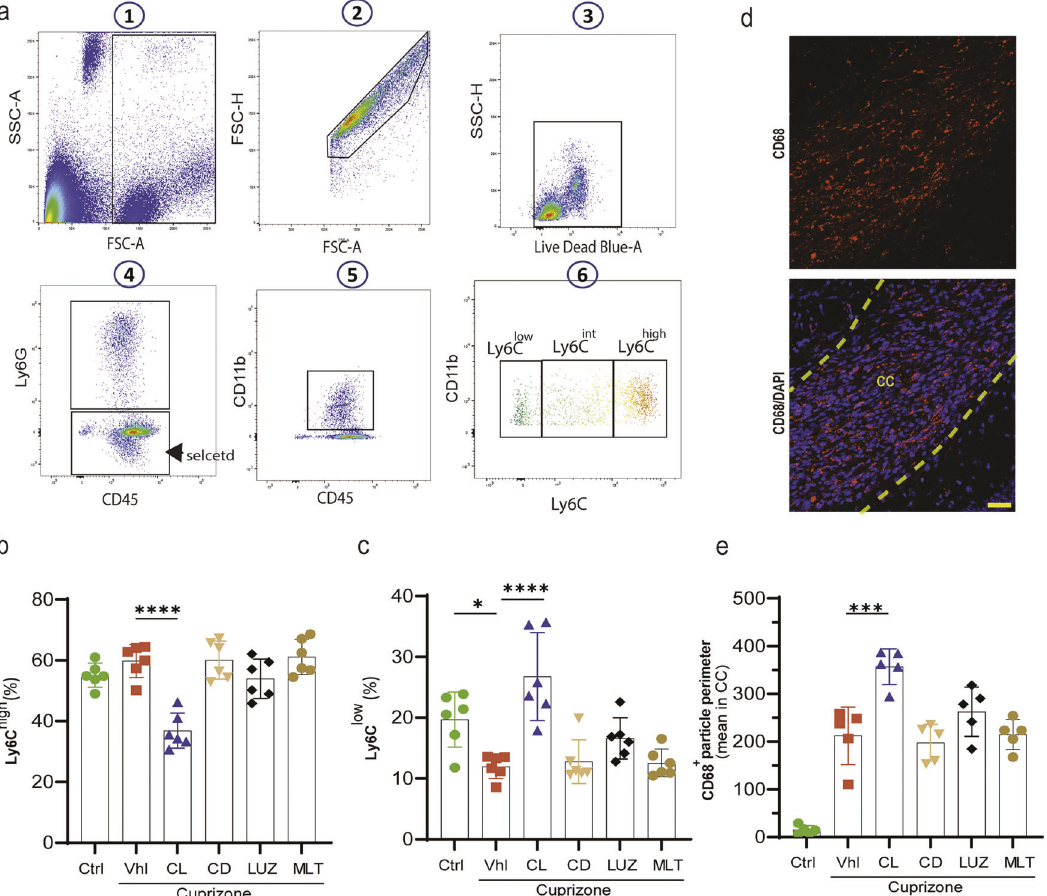
Fig. 6 Analysis of monocyte subtypes by FACS and phagocytosis. a Gating strategy for monocytes. After gating for live single cells, neutrophils were excluded from populations (CD45 + /Ly6G-) and then gated for CD11b + /CD45 + populations. These cells were further gated with CD11b + /Ly6C to analyze the percentage of Ly6Clow, Ly6Cint, and Ly6Chigh cells. b Percentage of classical in fl ammatory monocytes (Ly6Chigh). c Percentage of patrolling monocytes (Ly6Chigh). d Fluorescent staining of the phagocytosis marker CD68. e The corresponding quanti fi cations. All quanti fi cations were performed on peripheral blood samples collected at the same time ( n = 5 mice/group). Signi fi cance is indicated by ** p < 0.01 and **** p < 0.0001. Scale bars, 20 μ